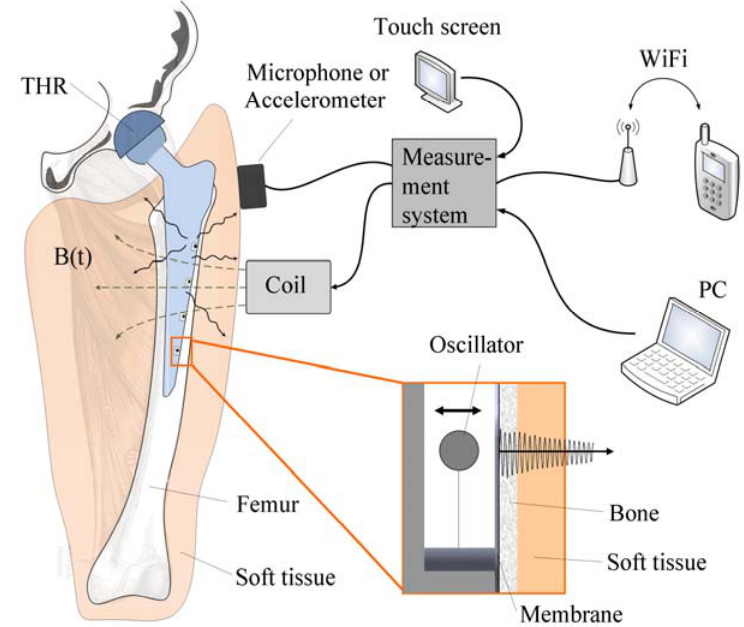
Figure 1. Schematic illustration of the passive sensor array inside a total hip